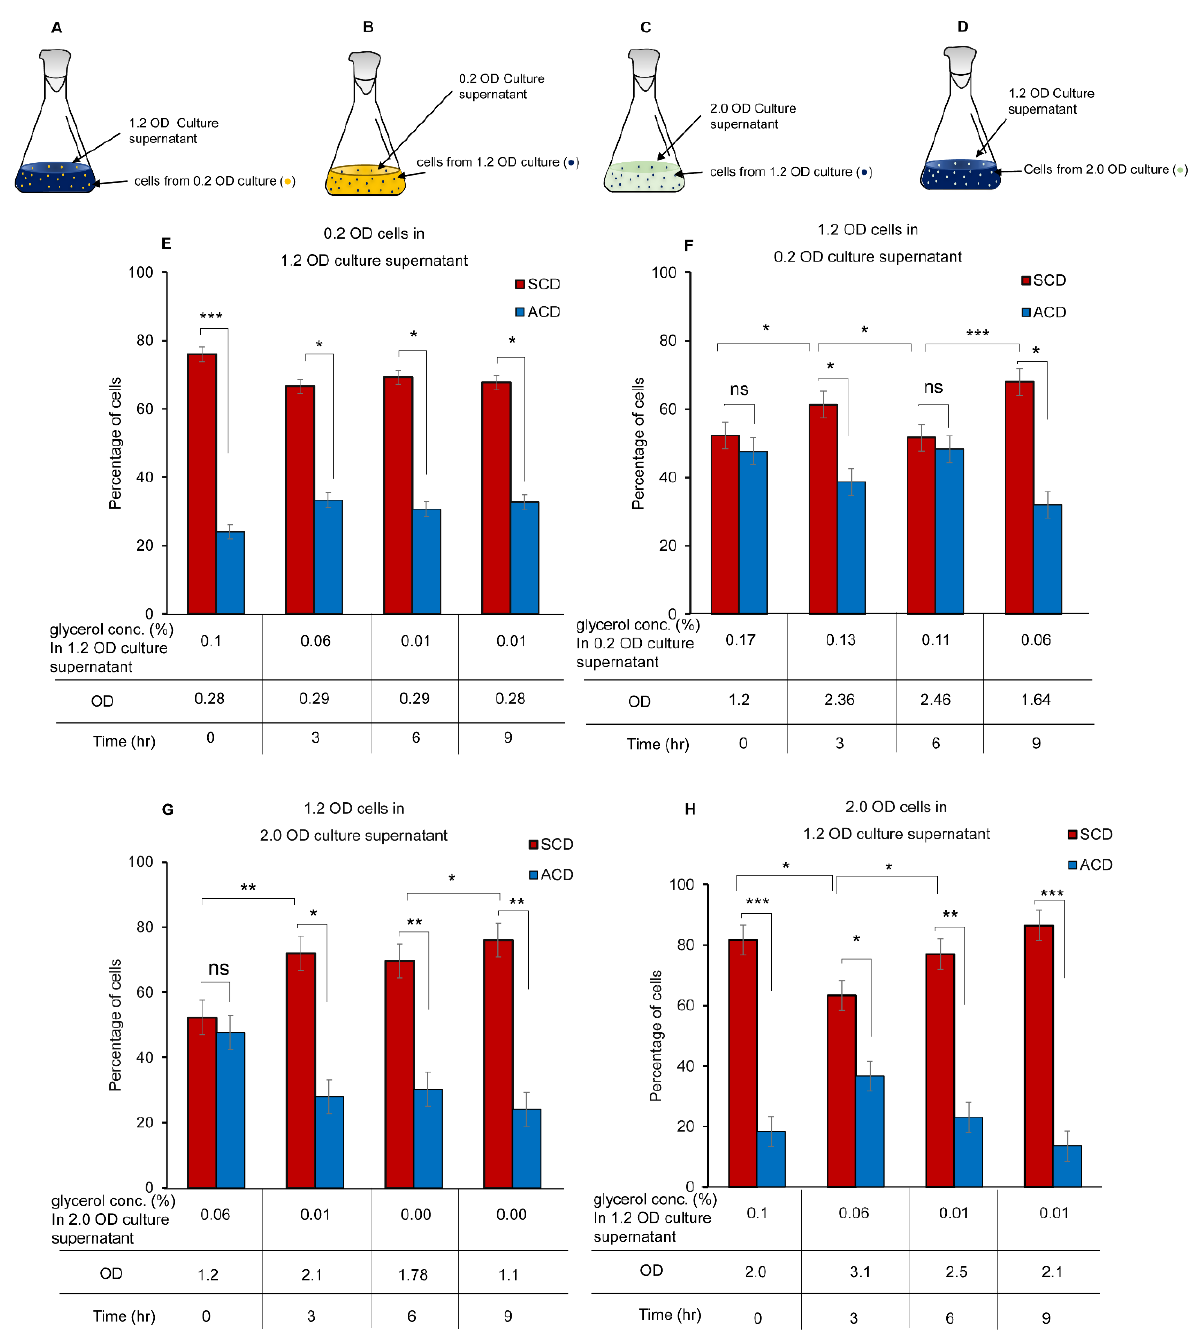
Figure 5. Proportions of the cells undergoing ACD/SCD after 3, 6, and 9 h when grown in the supernatant from another OD culture having different concentration of glycerol. ( A – D ) Cartoons for the transfer of the cells from one OD culture to the supernatant of another OD culture. Cartoons for the transfer of: ( A ) 0.2 OD cells to 1.2 OD culture supernatant; ( B ) 1.2 OD cells to 0.2 OD culture supernatant; ( C ) 1.2 OD cells to 2.0 OD culture supernatant; and ( D ) 2.0 OD cells to 1.2 OD culture supernatant. ( E – H ) The graphs for the ACD/SCD proportions, glycerol levels, and OD of the culture before and after transfer of the cells. ( E ) SCD and ACD proportion in 0.2 OD culture cells grown in 1.2 OD culture supernatant. ( F ) SCD and ACD proportion in 1.2 OD culture cells grown in 0.2 OD culture supernatant. ( G ) SCD and ACD proportion in 1.2 OD culture cells grown in 2.0 OD culture supernatant. ( H ) SCD and ACD proportion in 2.0 OD culture cells grown in 1.2 OD culture supernatant. ( n = 300, the data shown are for the biological triplicates and represented with mean values ± s.d. ns—no significance, p < 0.05 *, p < 0.01 **, p < 0.001 *** via two-tailed t